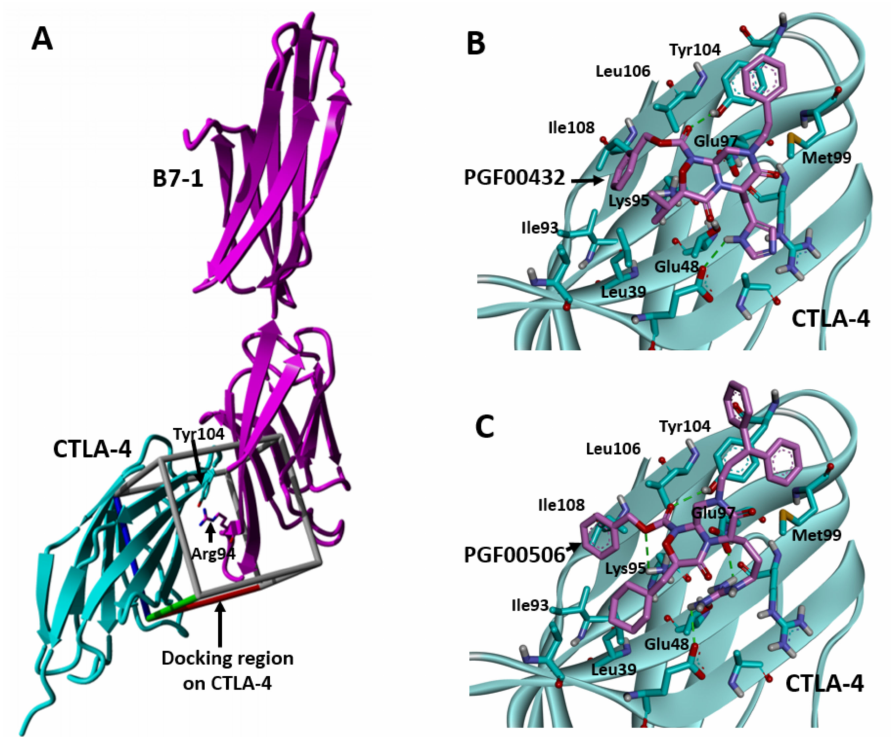
Figure 8. Predicted binding interaction of PGF00432 and PGF00506 with CTLA-4. ( A ) Crystal structure of B7-1/CTLA-4 complex (PDB code: 1I8L). Docking regions on CTLA-4 are derived from binding interface of the complex. ( B ) Predicted binding interaction of PGF00432 with CTLA-4. ( C ) Predicted binding interaction of PGF00506 with CTLA-4. Carbon, nitrogen, oxygen, and hydrogen are shown, respectively, in cyan (CTLA-4) or magenta (B7-1, PGF00432, and PGF00506), blue, red, and white. CTLA-4 and B7-1 are depicted as cyan and magenta ribbons, respectively. Dashed lines represent hydrogen bond